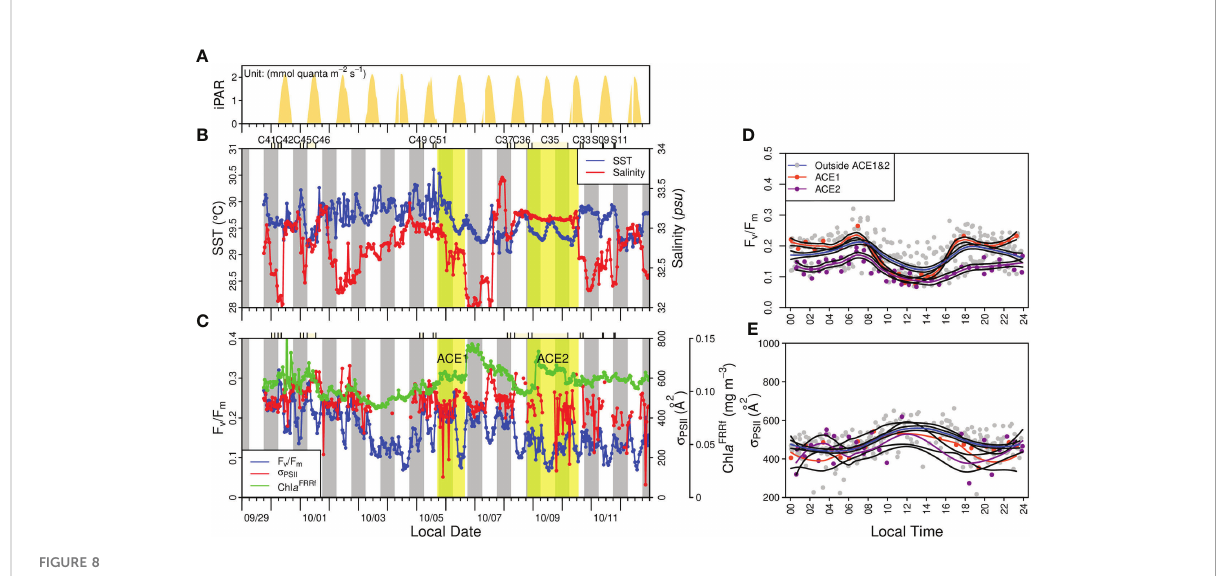
FIGURE 8 Same as Figure 5 but for the basin of the southeast SCS (Section